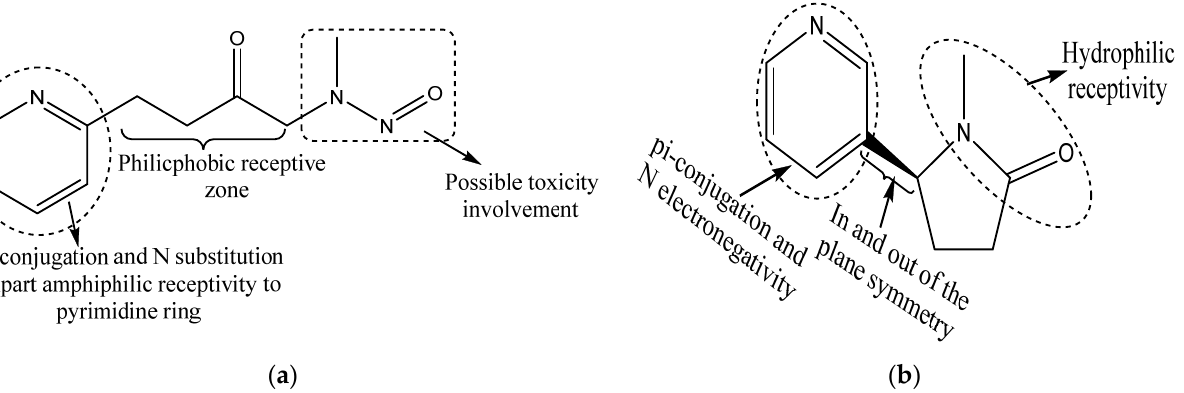
Figure 2. Chemical structures of ( a ) methylnitrosamino-pyridyl-butanone, a powerful carcinogenic agent involved in ER β activation, and ( b ) cotinine, a potential nicotine metabolite that inhibits aromatase activity and exhibits sex-dependent activities. Presence of pi-conjugation with N substitution and double-bonded oxygen in close proximity with nitrogen are the indicative features of possible toxic responses.